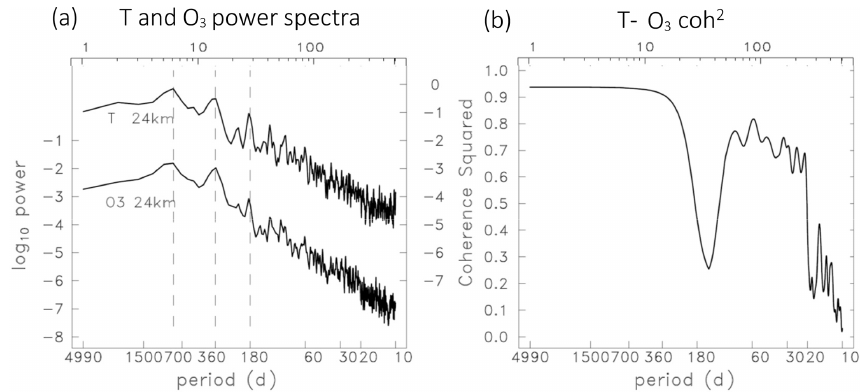
Figure 7. (a) Power spectra for GPS temperature and MLS ozone at 24km as a function of wave period. Logarithmic power units are K 2 (right axis) and ppmv 2 (left axis). The vertical dashed lines identify peaks in the spectra associated with the QBO, annual and semiannual cycles. The top logarithmic axis indicates the spectral estimates. (b) Coherence squared between temperature and ozone at 24km as a function of wave period.